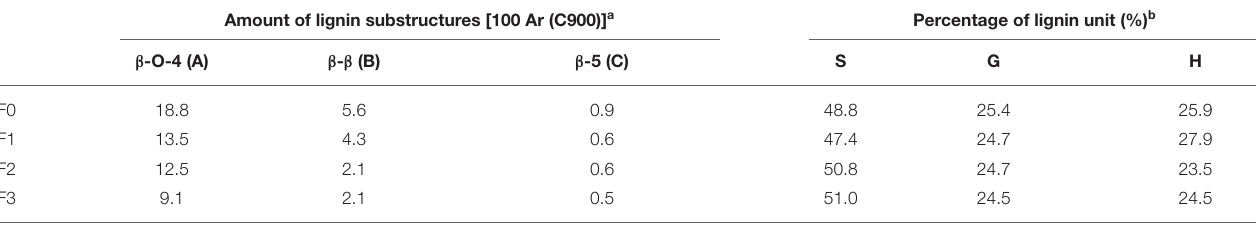
TABLE 2 | Quantitative amount of substructures in lignin fractions.